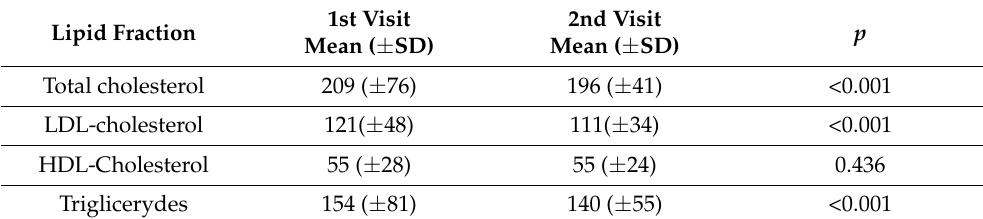
Table 3. Comparison of lipids profile between first and the second visit.